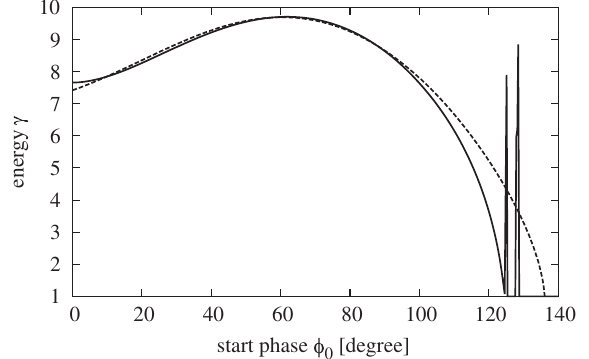
FIG. 5. Energy gain for a 1 1 cell rf gun cavity versus start phase 2 for α ¼ 1 . 8 . The solid line shows the result of a numerical integration. The analytical result, shown as a broken line, is the sum of the energy gain in the half-cell as in Fig. 4 and the energy gain in the full cell according to Eq. (9), where the synchronous phase [Eq. (20)] has been introduced. The peaks appearing in the numerical result at ≈ 130 ° will be discussed below.